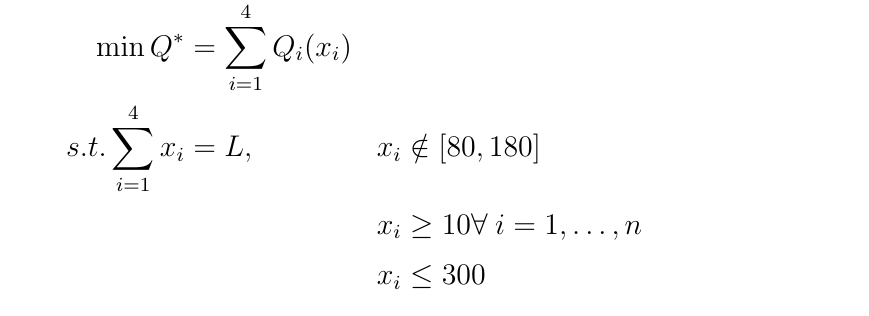
Figure 5. Efficiencies of generator in the Geheyan Hydropower plant for 110 m water